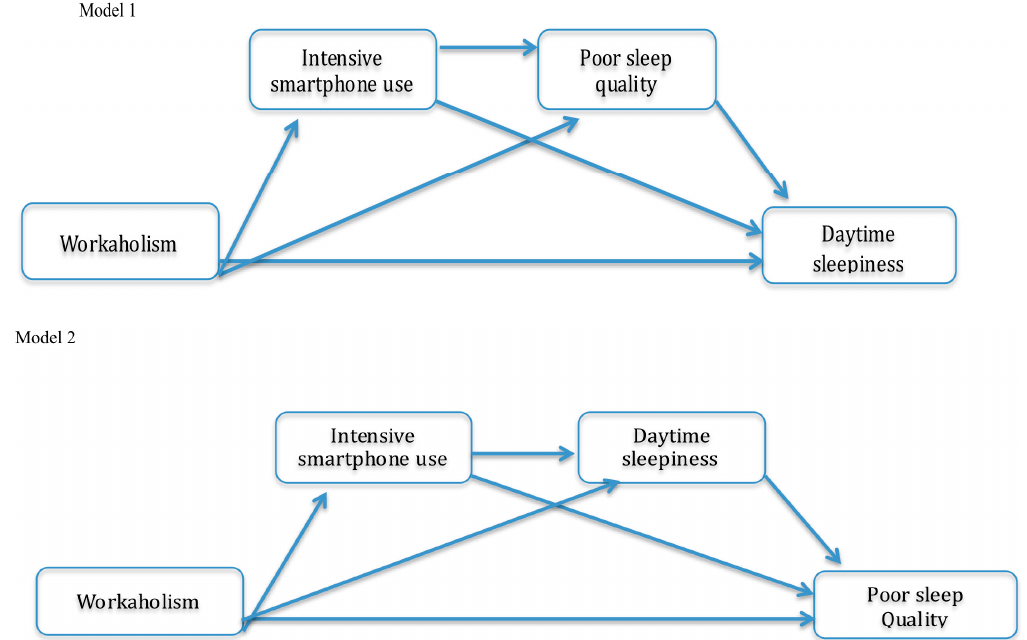
Figure 1. The two hypothesized serial multiple mediation models.